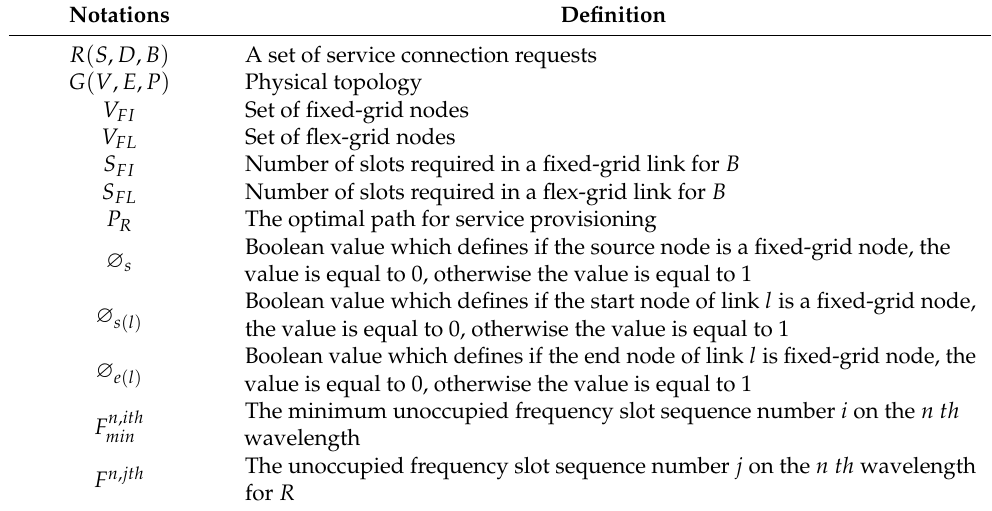
Table 1. Related parameters of BMA-RSA